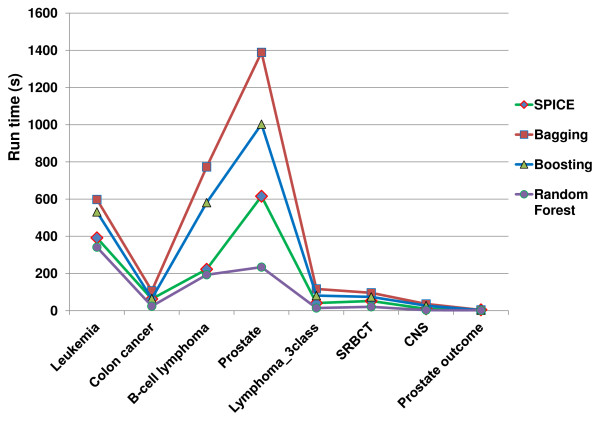
The runtime of Spicecompared to other methods.